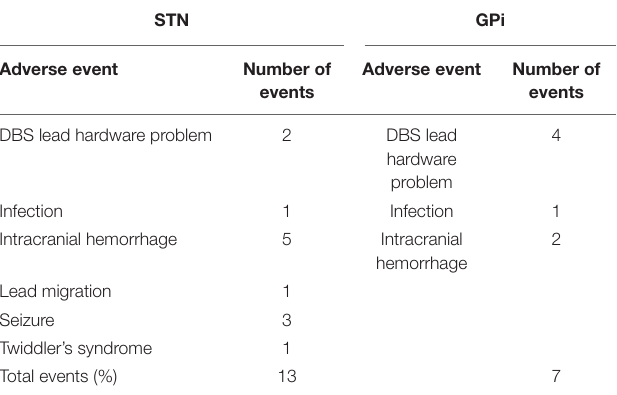
TABLE 2 | Summary of adverse events at one year follow-up. STN